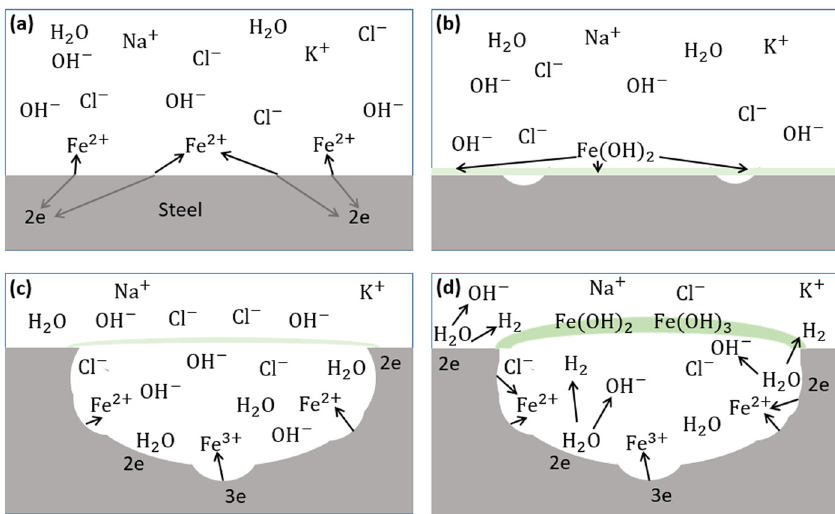
Figure 14: Schematic diagram of pitting corrosion mechanism under anodic potentiostatic application ( APA ) . ( a ) Fe dissolving to Fe 2 + at weak area of air - formed passive fi lm. ( b ) Fe 2 + combined with OH − forming Fe ( OH ) 2 passive fi lm. ( c ) Further dissolution of Fe to Fe 2 + and Fe 3 + and penetration of Cl − and OH − from bulk to trapped electrolyte. ( d ) Formation of green rust ( Fe ( OH ) 2 + Fe ( OH ) 3 ) and H 2